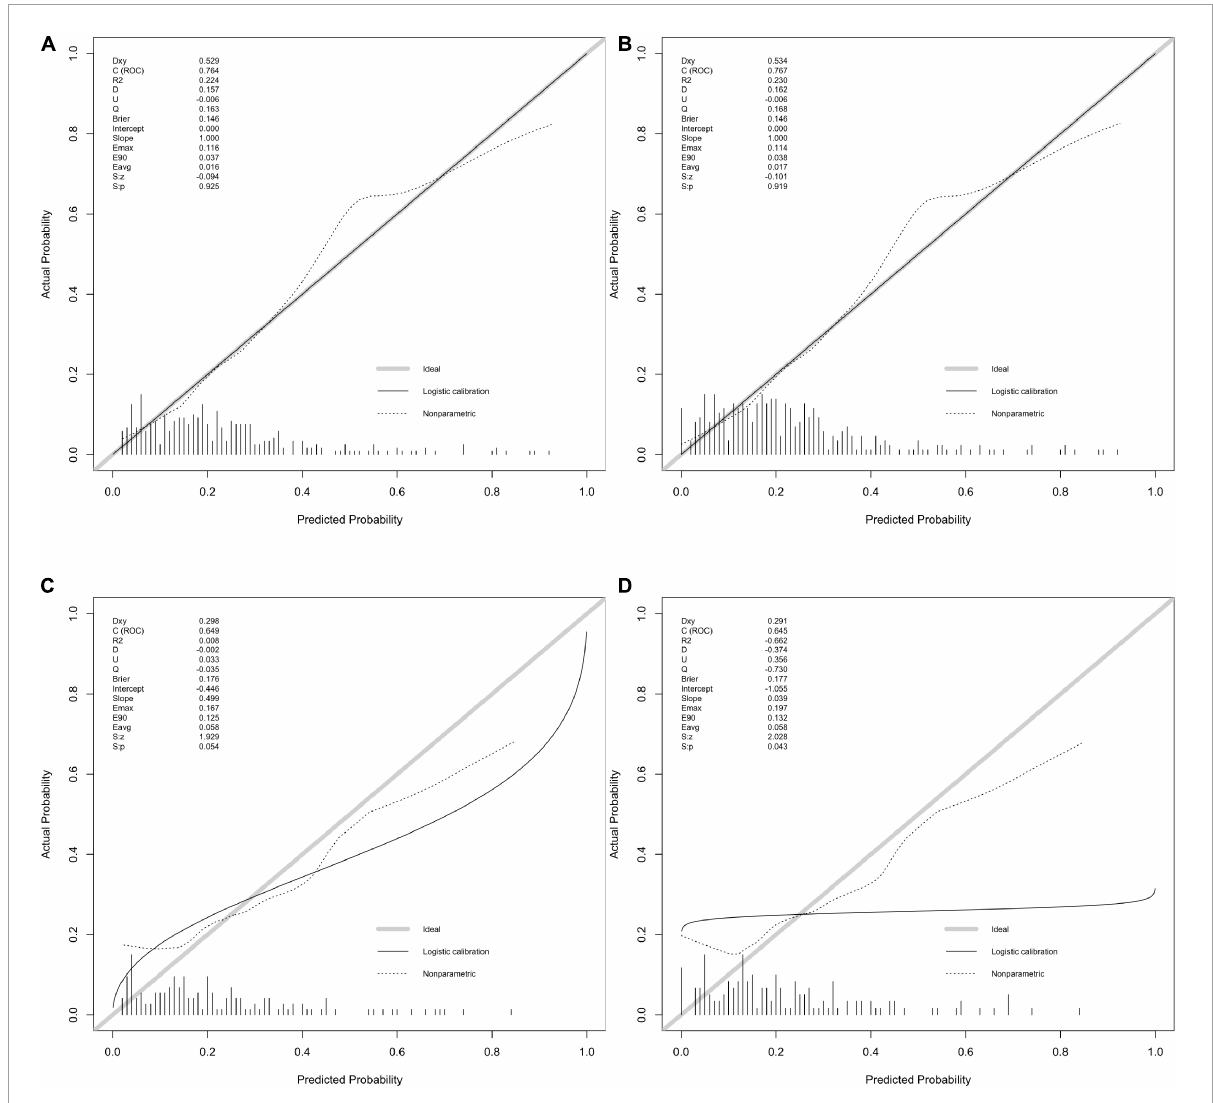
FIGURE2 The calibration with rms package. (A,B) Calibration plot for 6-factor and 5-factor logistic model for the developing in-house data which show the c(ROC) and S.p value. (C,D) Calibration plot for 6-factor and 5-factor logistic model for the validating in-house data which show the c(ROC) and S.p